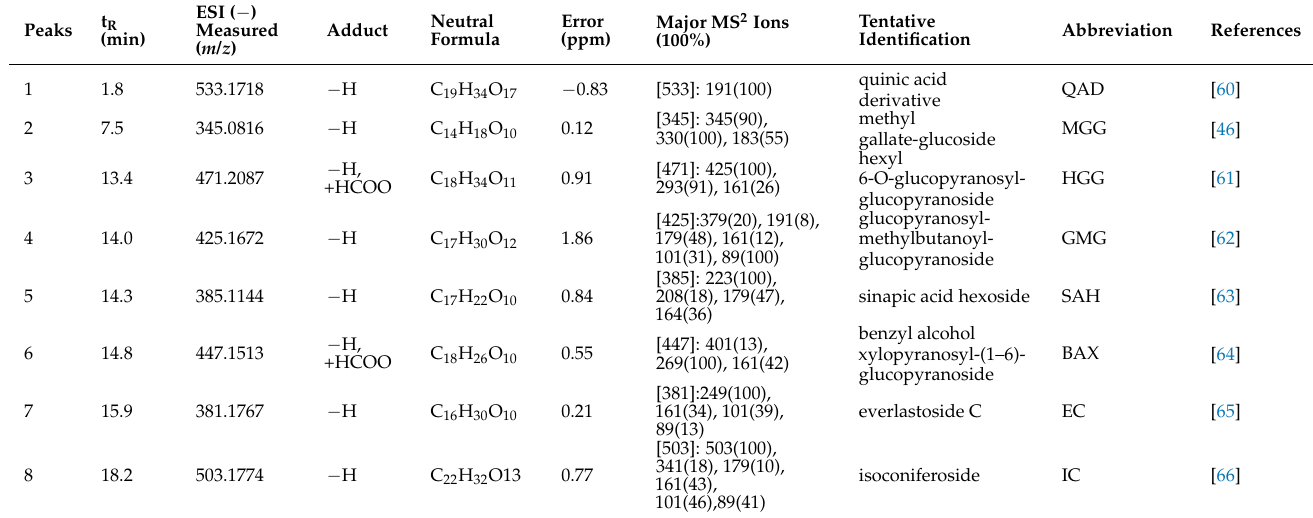
Table 2. Discriminative non-ginsenosides tentatively identified between cultivated and wild